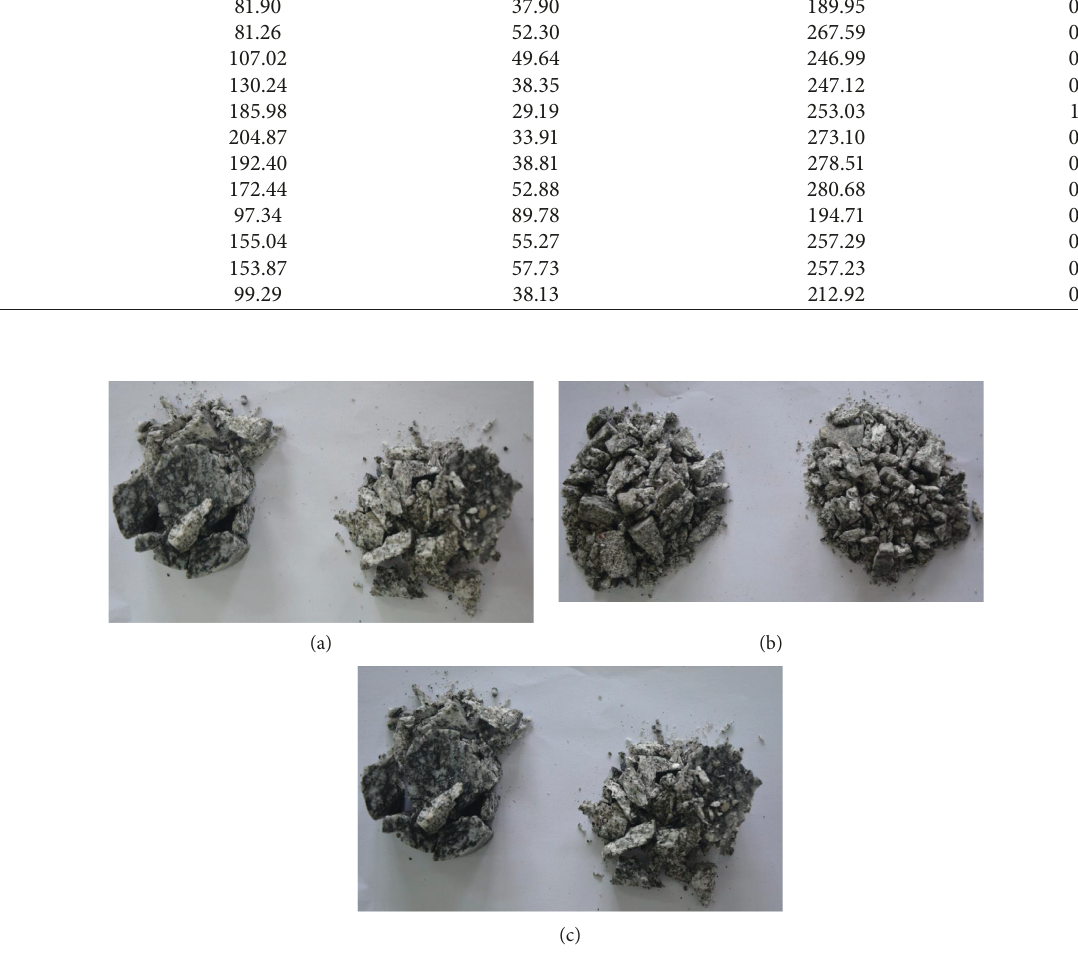
Figure 7: Photograph showing failure characteristics of (a) specimens #2 and #4, (b) specimens #6 and #8, and (c) specimens #13 and